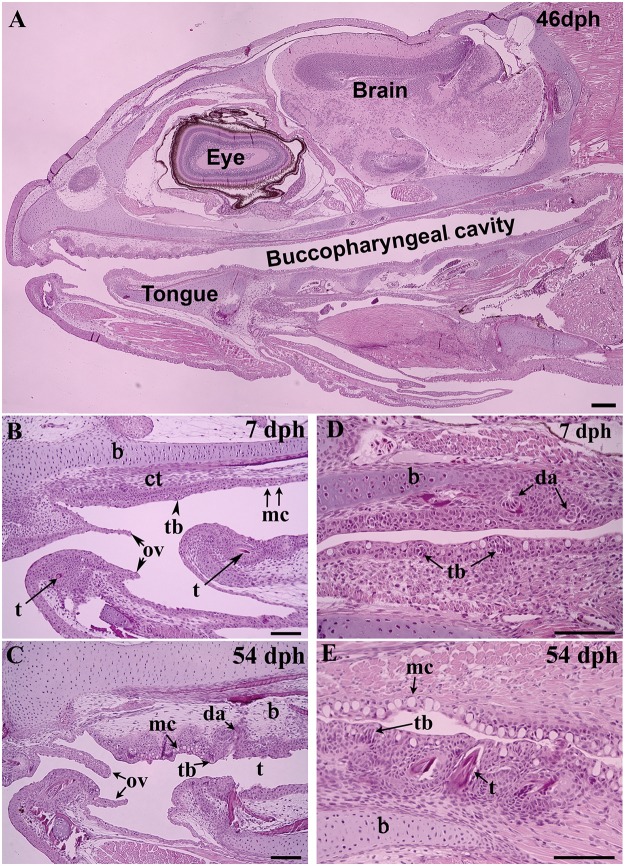
Representative sagittal sections of the buccopharyngeal cavity of Atlantic salmon juveniles at various time points (days post hatch [dph]).
(A) General overview of alevin head at 46 dph; (B-C) Development of anterior region of oral cavity: two visible oral valves, squamous epithelium scattered with mucus cells and taste buds, presence of mandibular teeth and lingual teeth at 7 dph (B); increase in number of mucus cells, taste buds and teeth at 54 dph (C); (D-E) Development of pharynx: squamous epithelium scattered with mucus cells and taste buds, and presence of pharyngeal teeth indicating by the dental alveoli at 7 dph (D); large increased number of mucus cells, taste buds and pharyngeal teeth at 54 dph. Abbreviations: b, bone; ct, connective tissue; da, dental alveolus; mc, mucus cell; ov, oral valve; t, tooth; tb, taste bud. Scale bar: (A) = 400 μm; (B-E) = 50 μm.